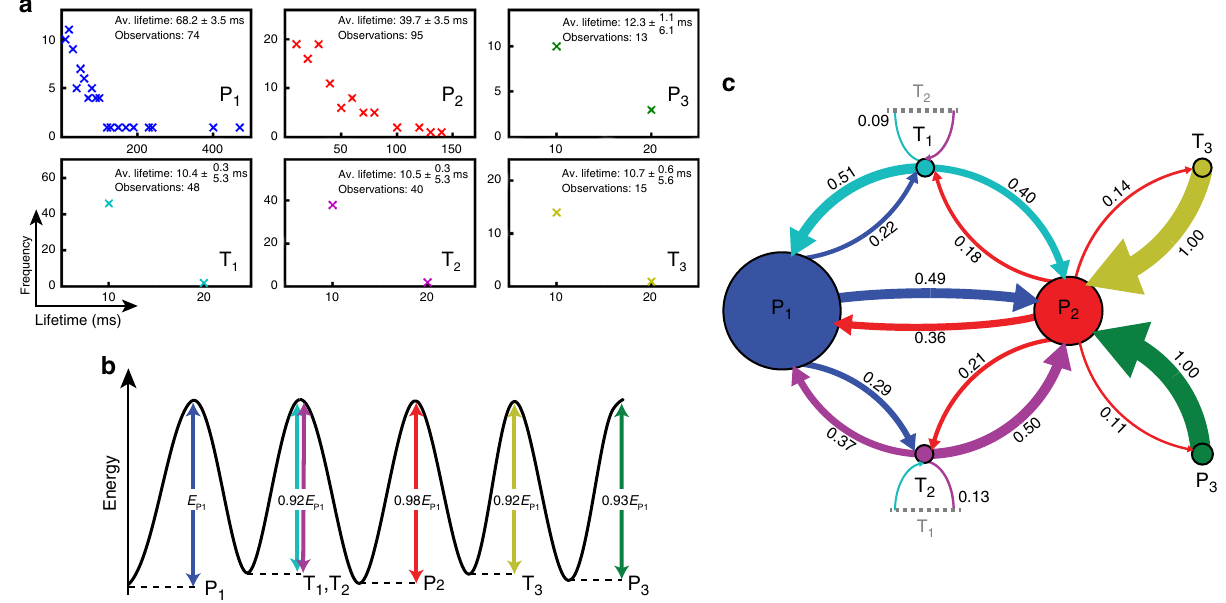
Fig. 3 Lifetime distributions, associated energy barriers and transition probabilities of each state. a Scatter plots of lifetime distributions for each of the observed con fi gurational states. Half the frame time (5 ms) was added to the lower bound in T x and P 3 lifetime uncertainties due to the short-lived nature of these states not always being captured individually per frame. b Relative energy barriers calculated using the Néel – Arrhenius equation and the average lifetime associated with each state. Each barrier height is given relative to the most stable state (P 1 ), which had an energy barrier height on the order of 0.55 ev. c Observed state transitions represented as a Markov chain process, only including transitions observed more than once. Circles (arrows) representing each state (transition) are scaled to the relative lifetimes (transition